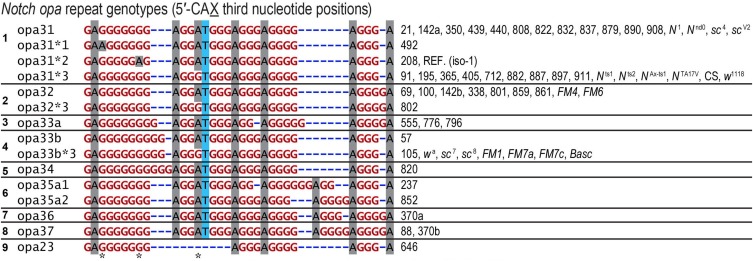
Diverse RAL nucleotide sequences for the opa repeats of D. melanogaster encode nine distinct pQ-isoforms of Notch. The opa repeat genotypes (third codon positions of 5′-CAX shown) also demonstrate that the longest repeats of 5′-CAG coincide with the most polymorphic regions, consistent with the effect of repeat length on replication slippage frequency and nucleotide substitution rates. We also note that the 3′ region of the opa repeats corresponds to a repeat of repeats, (GGGGA)2-3, and derivatives thereof. This region is also a hypervariable site. Asterisks indicate three positions where synonymous substitutions were observed. Canton-S (CS) and other genotyped stocks are also listed. BDGP stock #26820, which is not listed, carries a UAS-N-FULL cDNA featuring a stable opa31*3 nucleotide sequence as determined in QC experiments (see Materials and Methods).